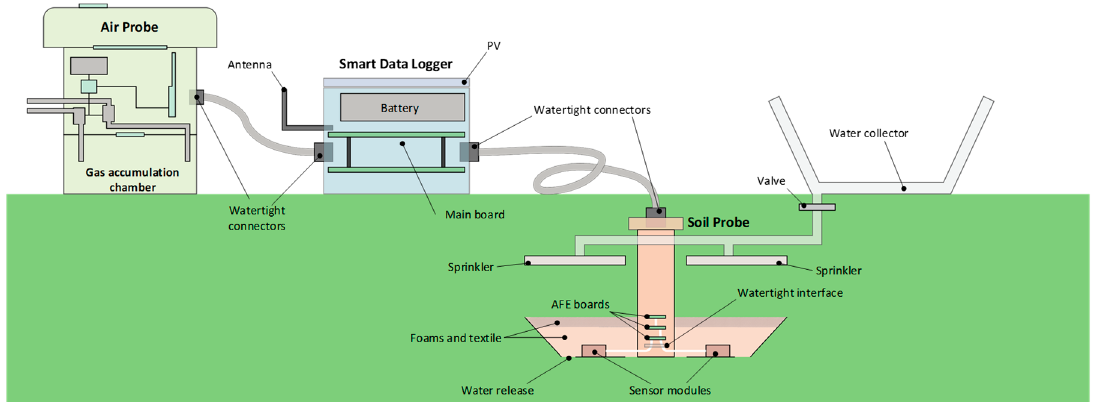
Figure 2. Secure Connected Node physical design .